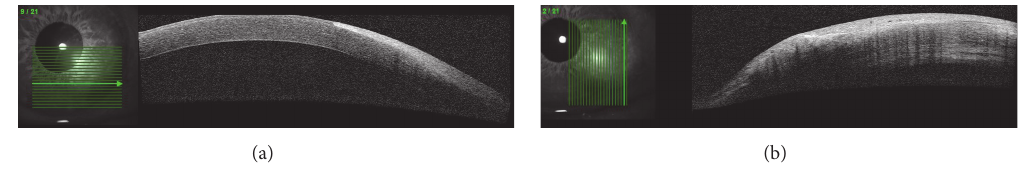
Figure 4: High resolution anterior segment optical coherence tomography of a corneal intraepithelial neoplasia demonstrates (a) a sharp delineation between normal and abnormal epithelium and (b) a thickened and hyperreflective